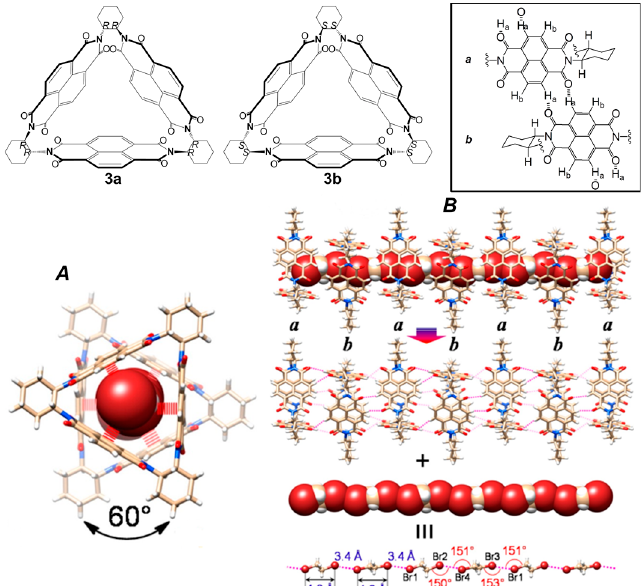
Figure 4. R - ∆ and S - ∆ macrocycles 3a , b (top left). Schematic view of the [C–H ··· O] interactions between the NDI units (top right): ( A ) bottom: top view showing that the coaxial DBA chain is stabilized through latitudinal [Br ··· π ] interactions; and ( B ) bottom schematic illustration of nanotubular structure. Partially reproduced with permission from Ref. [45] (Copyright American Chemical Society, 2014).